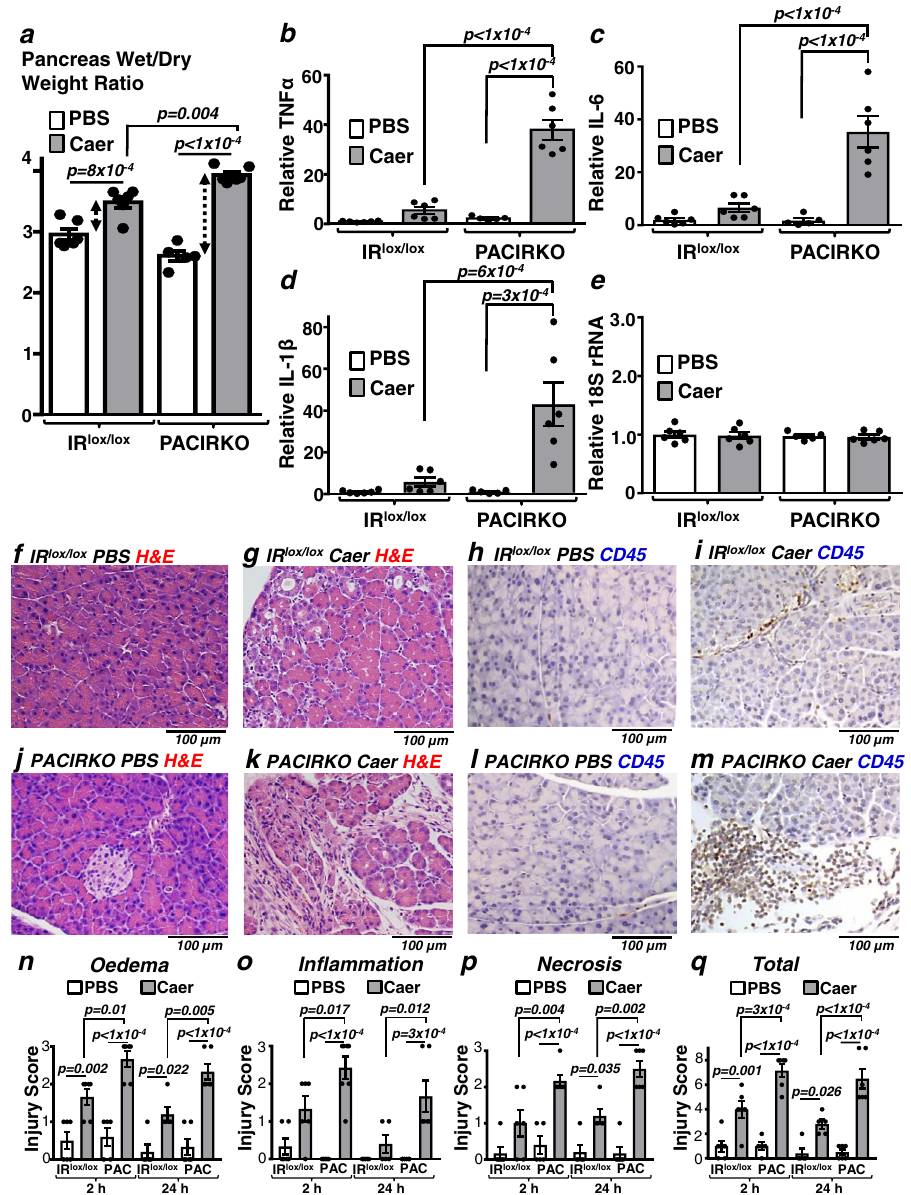
Fig. 3 Caerulein-induced pancreatitis is more severe in PACIRKO vs IR lox/lox mice. Pancreatitis was induced in control double fl oxed insulin receptor (IR lox/lox ) mice vs Pancreatic Acinar Conditional Insulin Receptor Knock Out (PACIRKO) mice that lack insulin receptors (IRs) by caerulein (Caer; 50 µ g/ Kg × 8 hourly IP injections over 2 days) or phosphate-buffered saline (PBS) as a control and blood/tissue was harvested 2 and 24 h after the last injection. Multiple readouts of pancreatitis include; pancreatic tissue oedema (wet/dry weight ratio, a ), cytokine expression (qPCR of tissue mRNA; TNF α , b ; IL-6, c , IL-1 β , d ; and the housekeeping 18 S rRNA, e ), histological signs of injury (haematoxylin and eosin (H&E), f , g , j and k ), immunohistochemistry of the in fl ammatory marker, CD45 (brown) ( h , i , l and m ). n – q Histology injury scores (where 3 is the most severe) for oedema ( n ), in fl ammatory cell in fi ltration ( o ), necrosis ( p ), and total score ( q ; sum of other scores). Group sizes were: 2 h harvest, IR lox/lox PBS, n = 6; IR lox/lox Caer, n = 6; PACIRKO PBS, n = 5; PACIRKO Caer, n = 6; 24 h harvest, IR lox/lox PBS, n = 5; IR lox/lox Caer, n = 5; PACIRKO PBS, n = 6; PACIRKO Caer, n = 6. Signi fi cance (exact p values as indicated) was determined by one-way ANOVA with Sidak ’ s multiple comparisons. Data are presented as mean value ±